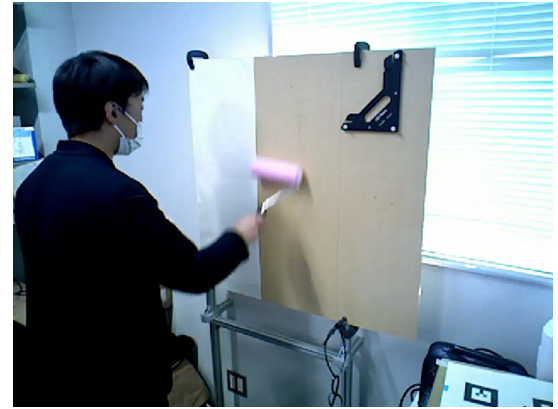
Fig. 1 Wall painting using a roller